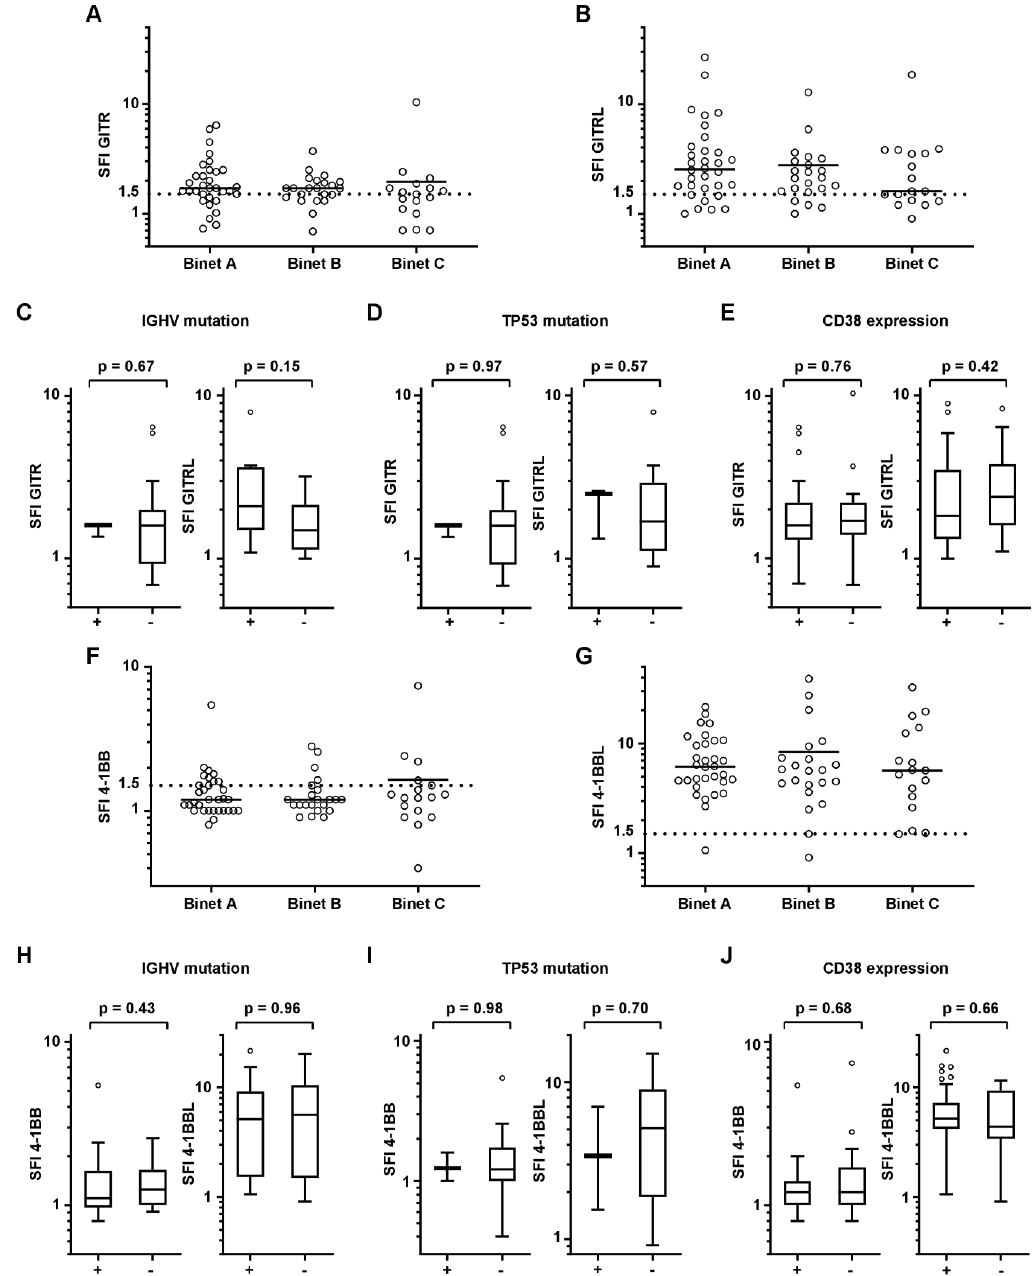
Figure 3. GITR, GITRL, 4-1BB, or 4-1BBL expression of CLL cells are classified by clinical characteristic. Binet stages, IGHV mutation, TP53 mutation, and CD38 positivity of CLL cells classified for each GITR, GITRL, 4-1BB, and 4-1BBL expression (SFI). ( A , B , F , G ) Distribution of GITR/GITRL/4-1BB/4-1BBL expression (SFI) according to Binet stage at sample acquisition is shown (single values, mean). ( C , H ) IGHV mutation status (- unmutated, + mutated). ( D , I ) TP53 mutation status (unmutated, + mutated). ( E , J ) CD38 expression (>30%) of CLL cells are demonstrated for GITR/GITRL/4-1BB/4-1BBL expression (SFI). ( C – E , H – J ) Statistical analysis with Mann-Whitney-U test.